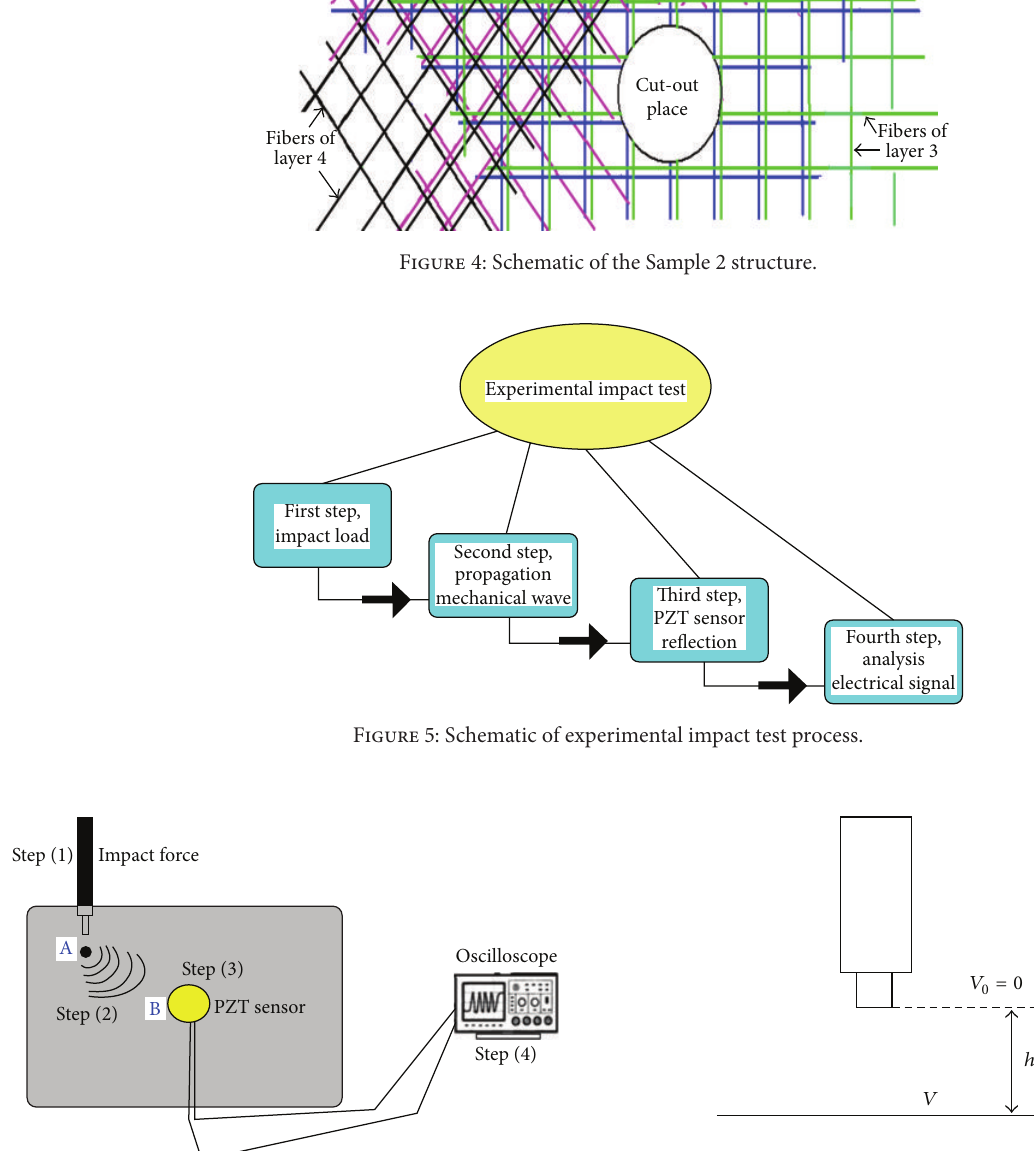
Figure 7: Release of the rod on the composite